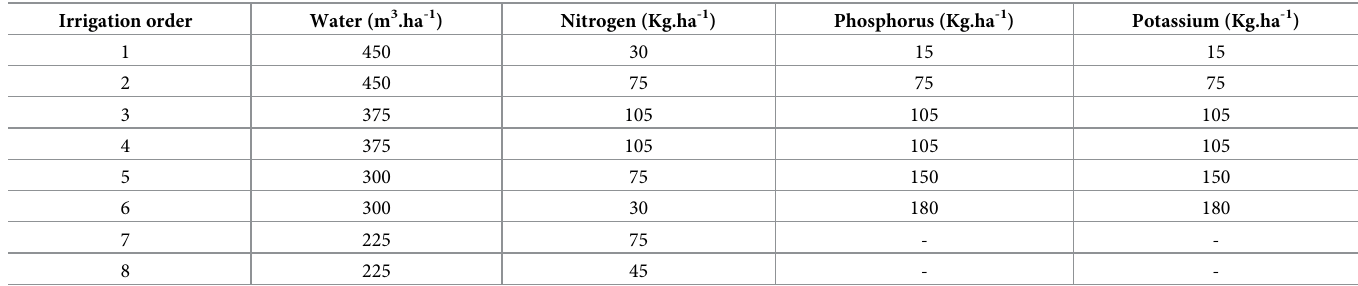
Table 4. The supply of water and nutrients (fertilizer) for each irrigation (round irrigation 2020). Irrigation